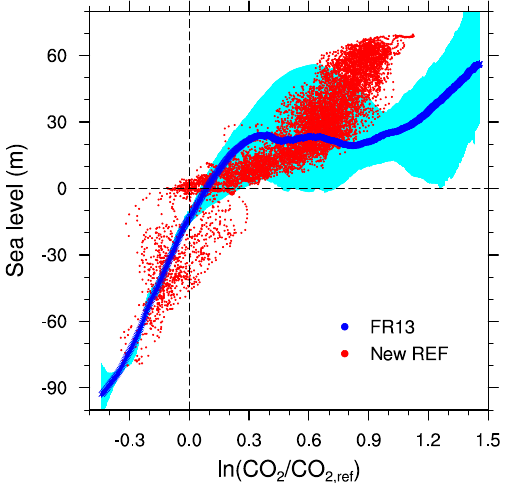
Figure 7. Relation between the logarithm of CO 2 divided by the PI value of 280ppm and ice-volume-equivalent sea level anomalies with respect to PI for the reference simulation (red dots) compared to the median case of the probabilistic data analysis in Foster and Rohling (2013) (FR13, blue dots) with their 95% uncertainty range in